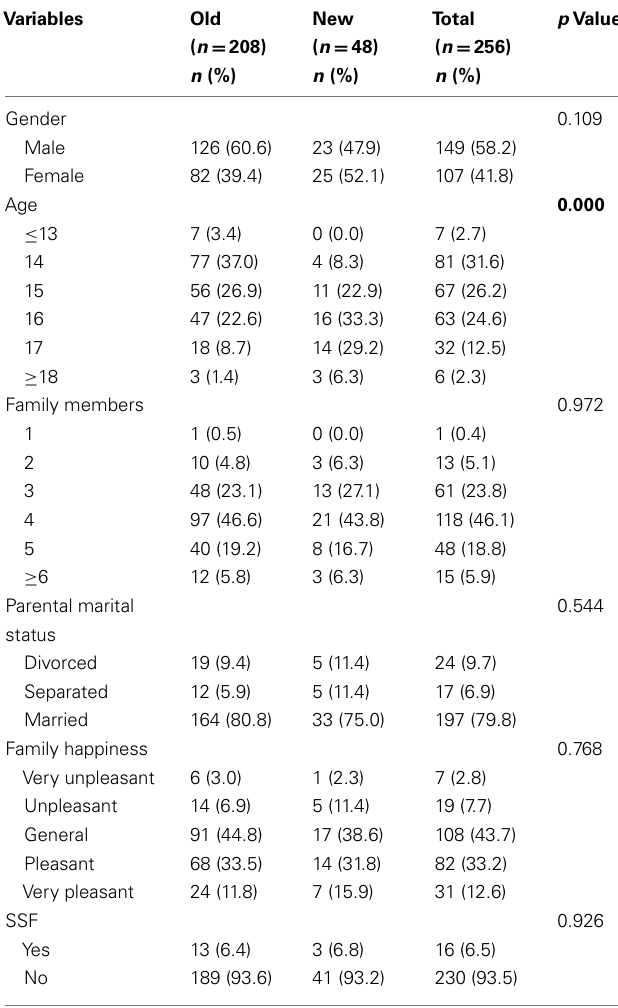
Table 2 | Participant characteristics of P.A.T.H.S. Secondary 3 old and new students